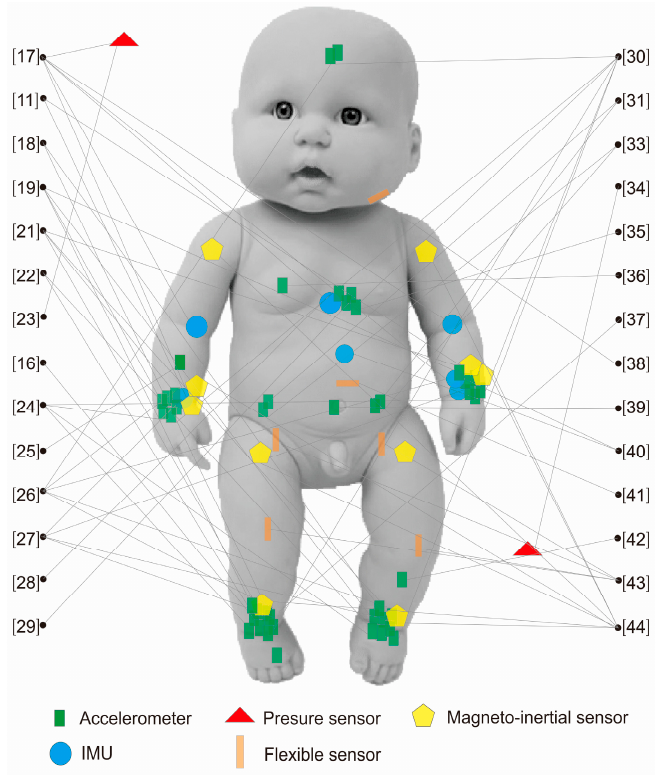
Figure 3. Infographic of sensor placements.